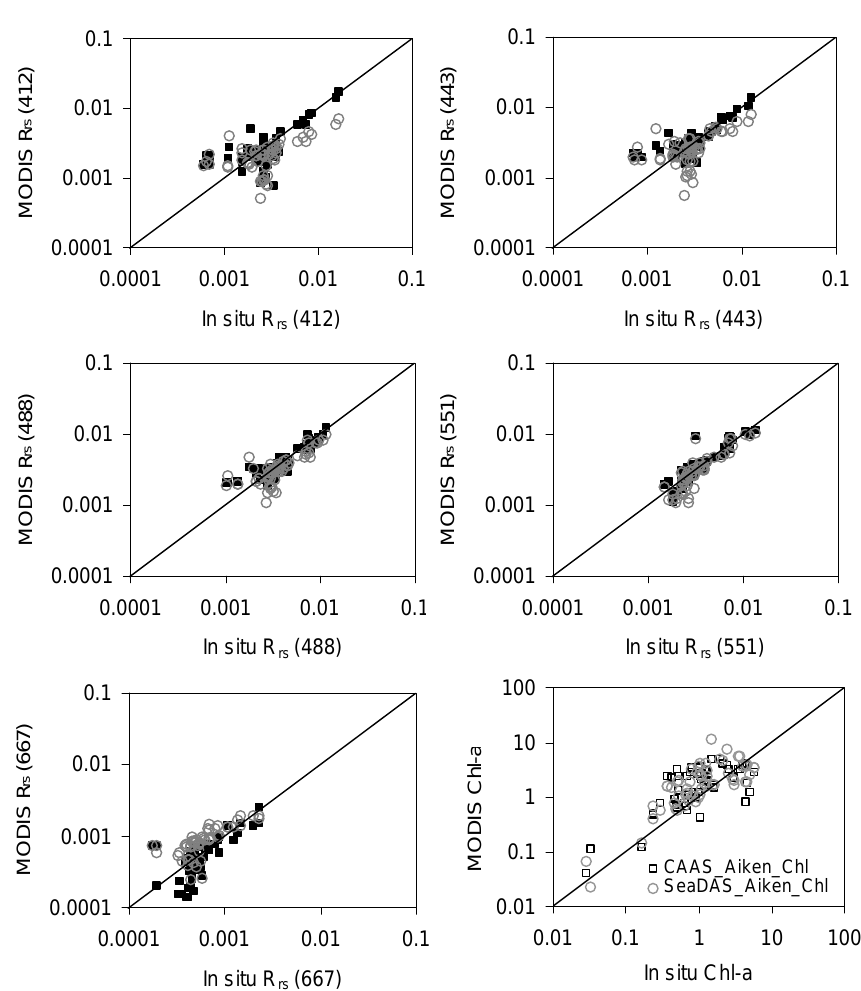
Fig. 9. Comparison of in situ measurements of the remote sensing reflectance with coincident MODIS-Aqua spectra (from various regional waters) from the SeaDAS and CAAS algorithms. The Chl- a concentrations retrieved from the Aiken bio-optical algorithm using CAAS R rs and SeaDAS R rs are shown in the bottom-right corner panel.